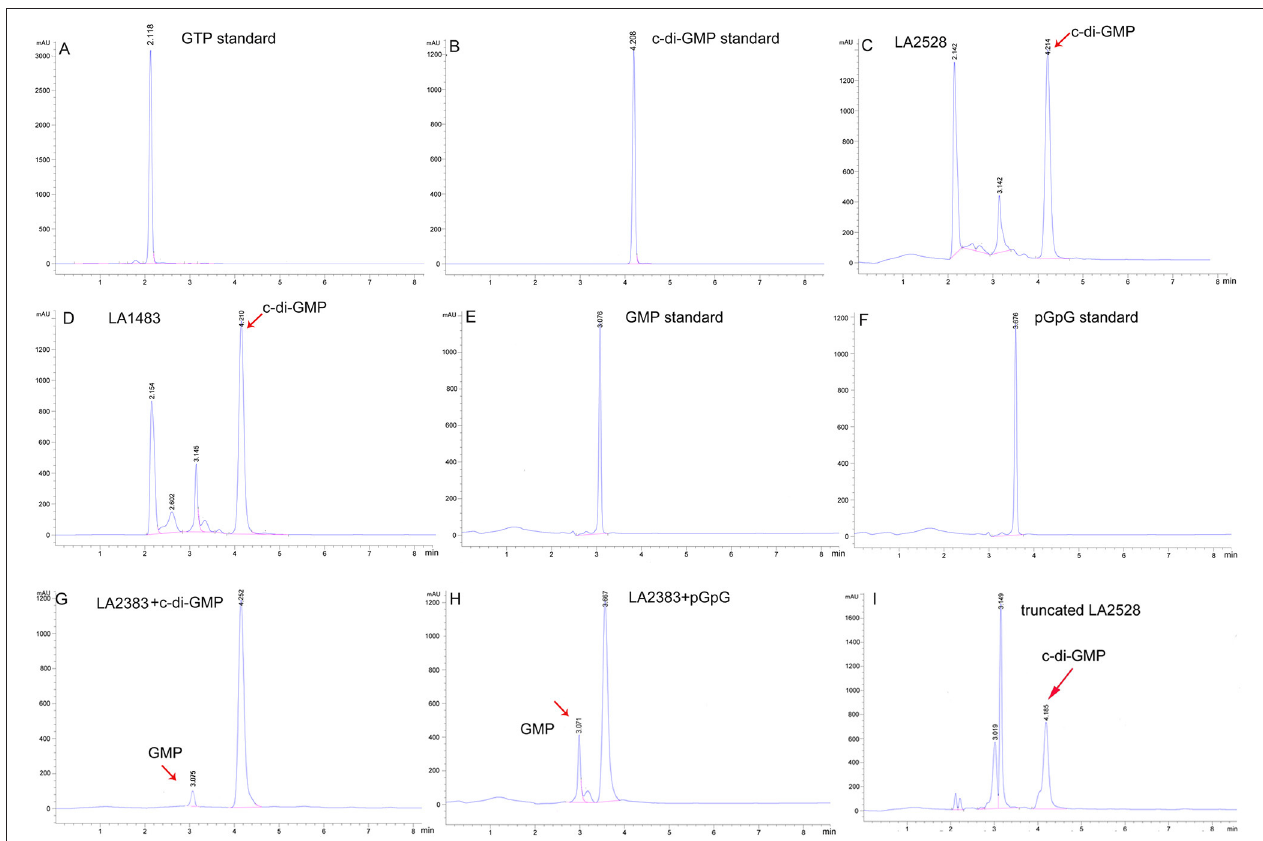
FIGURE 4 | Selected c-di-GMP metabolic proteins from L. interrogans showed DGC and PDE activity in vitro. Enzyme reactions were performed as described in material sections. GTP was used as substrate in DGC activity assays. c-di-GMP or pGpG was used as substrate in PDE activity assays. (A) The retention time of GTP standard is 2.1min; (B) The retention of c-di-GMP standard is 4.2min; (C) LA2528 reaction product; (D) LA1483 reaction product; (E) The retention time of GMP standard is 3.0min; (F) The retention time of pGpG standard is 3.6min; (G) LA2383 reaction product with substrate c-di-GMP; (H) :LA2383 reaction product with substrate pGpG; (I) Truncated LA2528 reaction product. Peaks represent retention times. Red arrows represent reaction